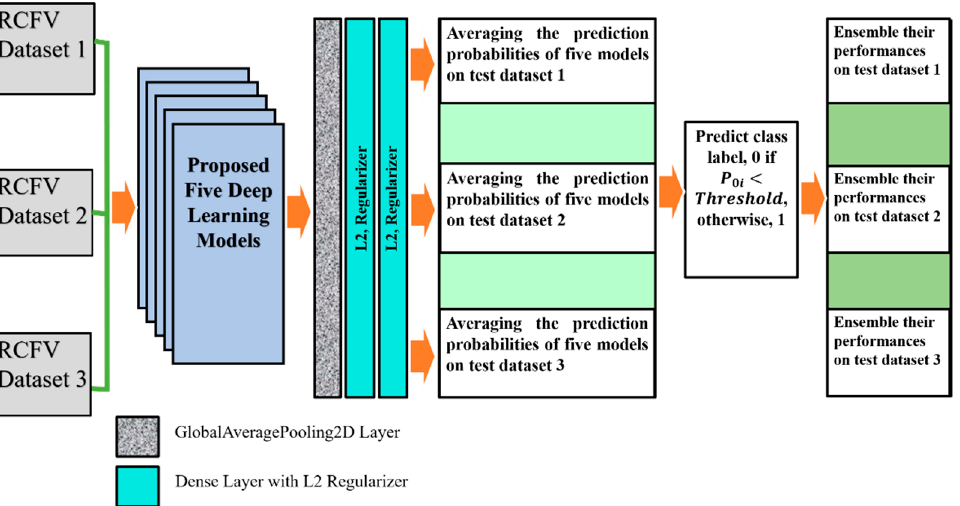
Figure 4. An ensemble learning based on simple averaging of probability prediction values using multiple DL models in three RCFV datasets.